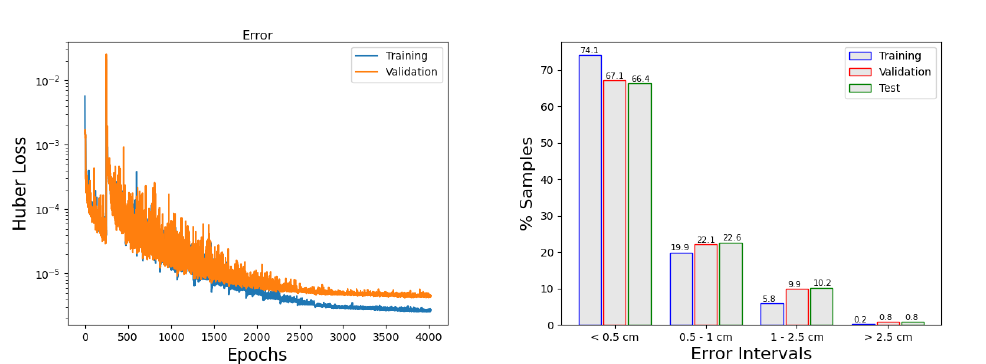
Figure A2. Train and validation error during training ( left ) and percentage of predictions in certain error intervals in the maximum height problem ( right ) with 12 forecast points. Table A2. Mean and maximum absolute errors for the predicted maximum heights in 12 fore- cast points.